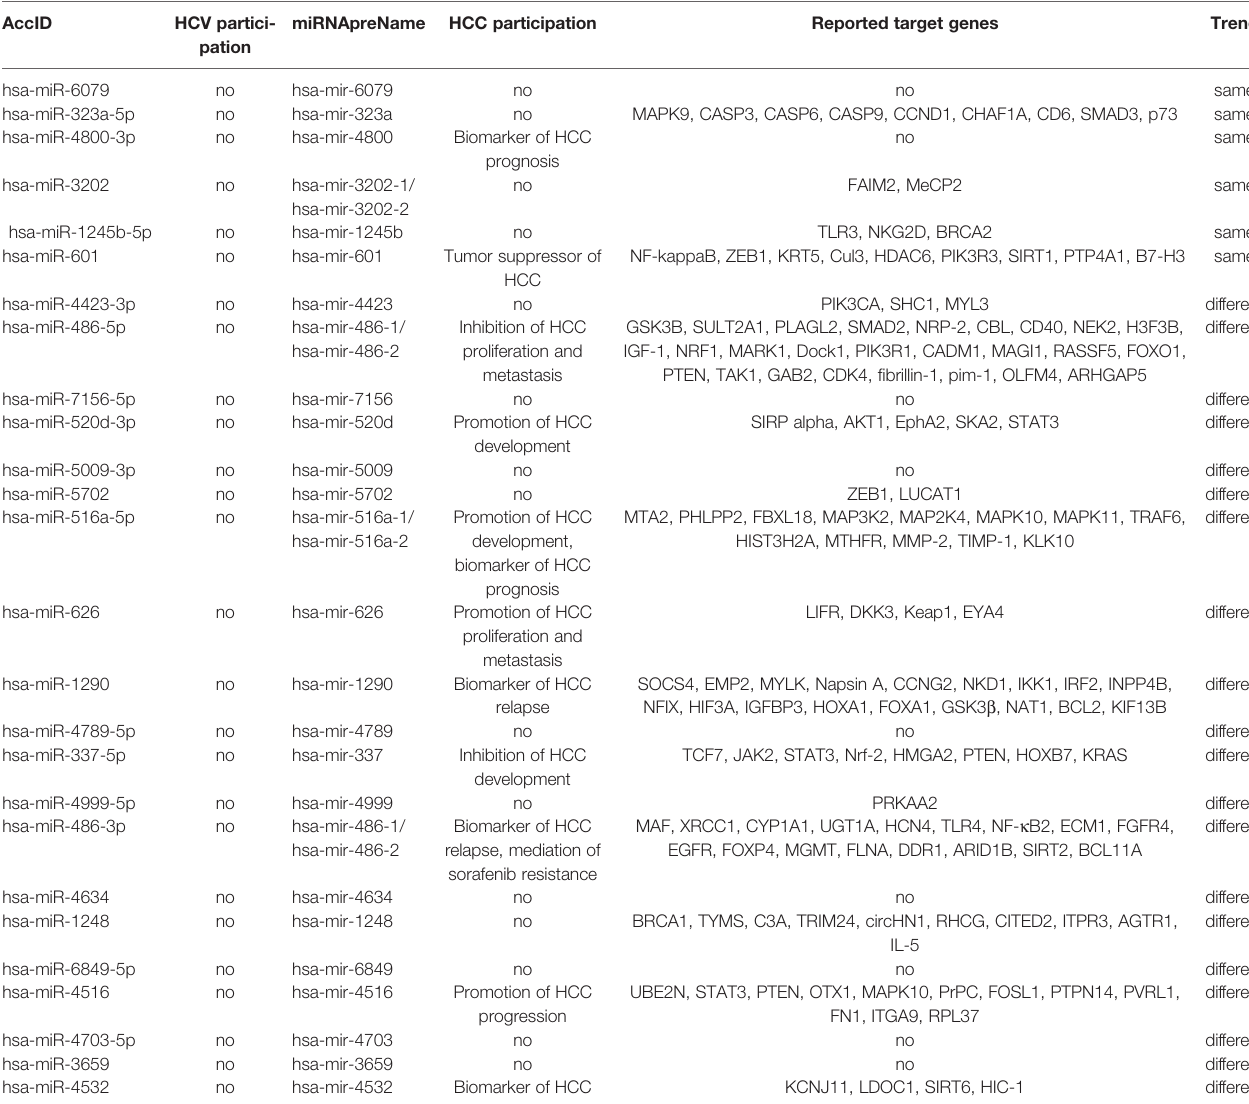
TABLE 1 | Information of miRNAs with indicated